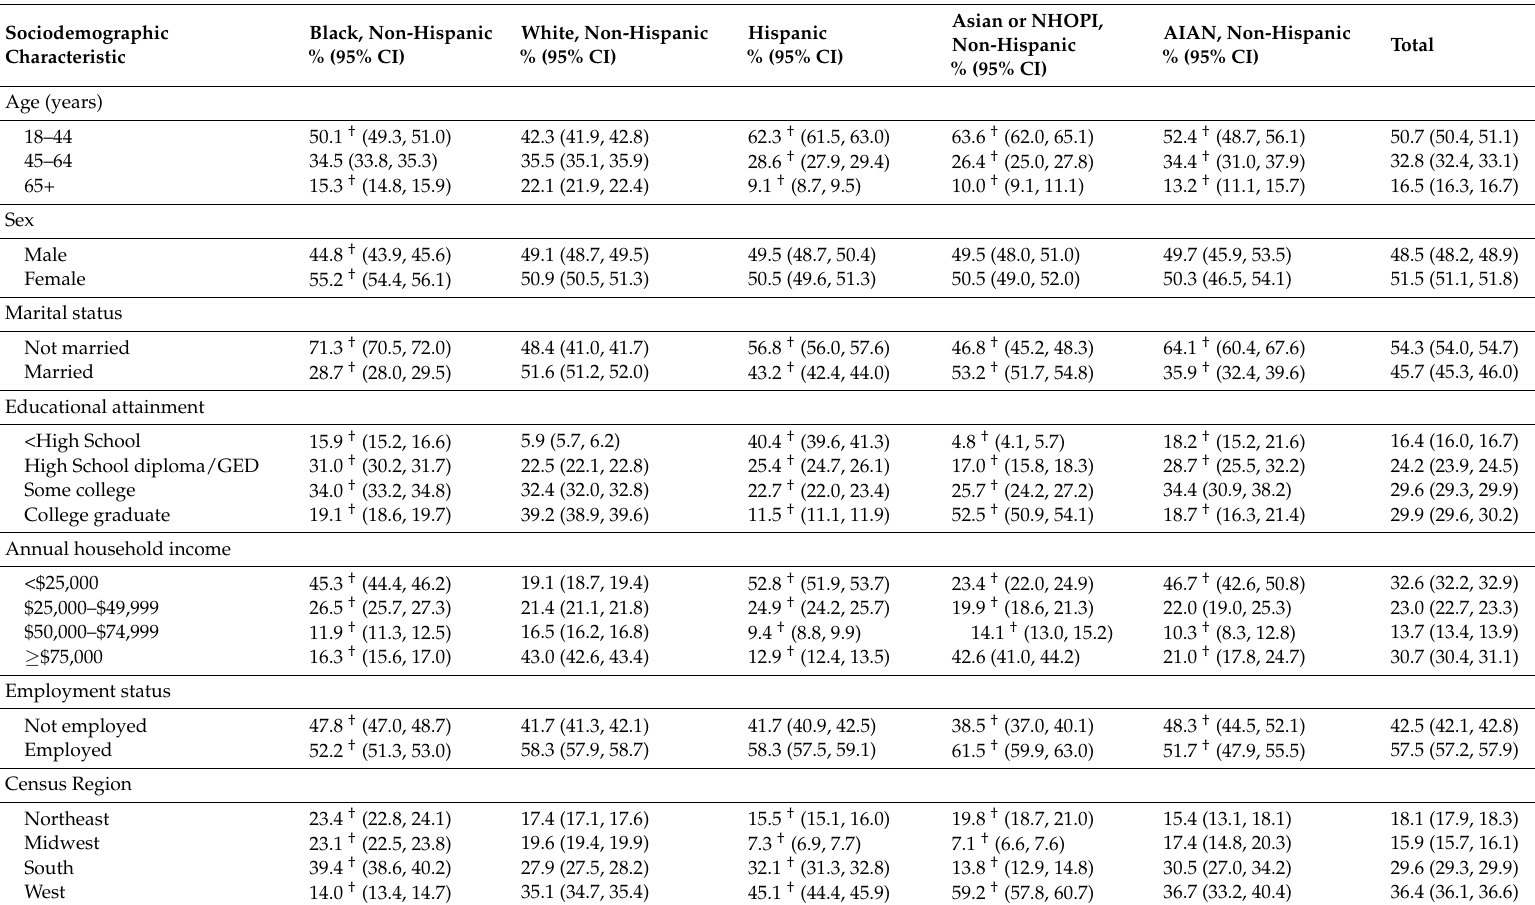
Table 6. Sociodemographic characteristics of large Central metropolitan dwelling adults* by race and ethnicity: Behavioral Risk Factor Surveillance System, United States,